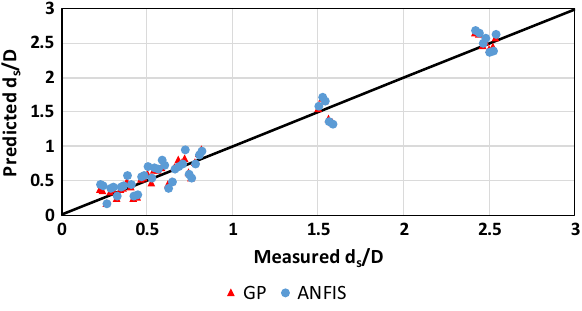
D versus measured val- s /